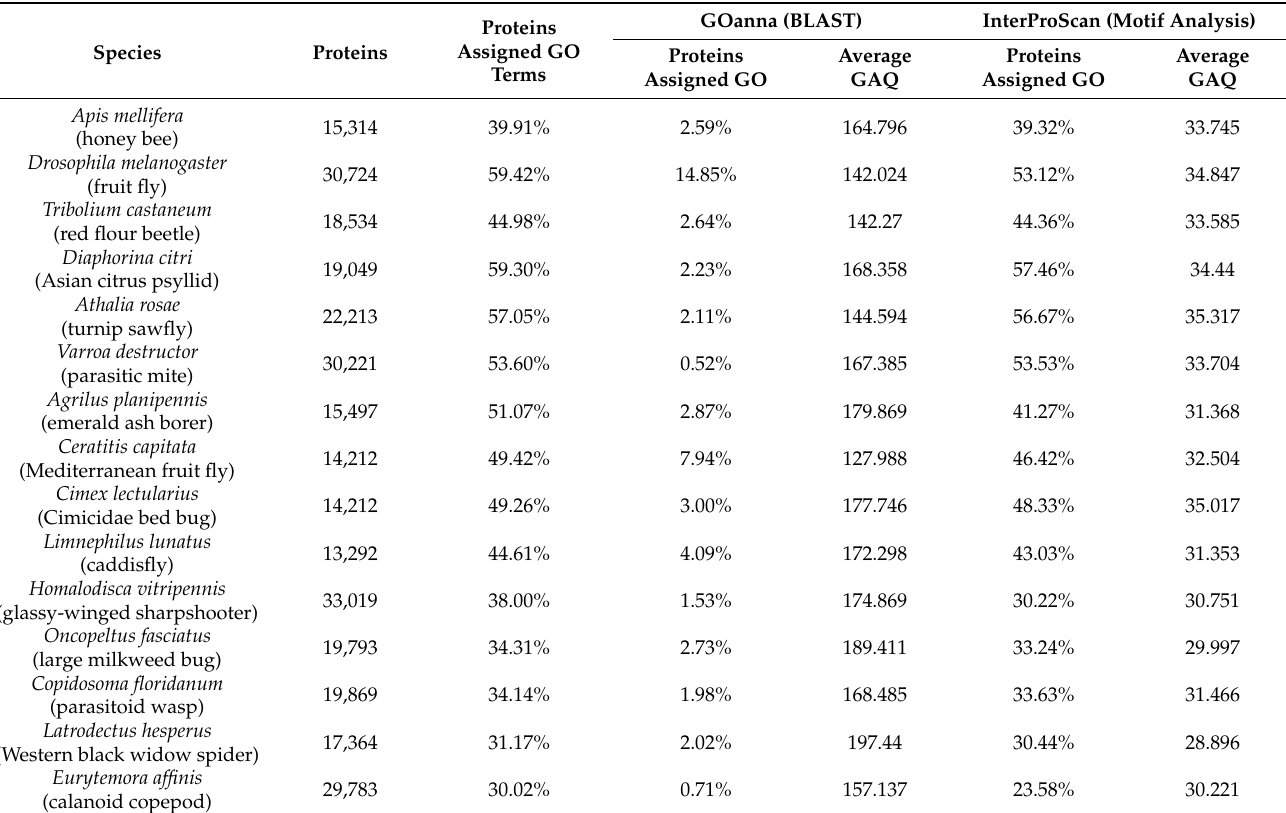
Table 5. GOanna and InterProScan results for arthropod genomes selected for this study. The test species are sorted by their GO term